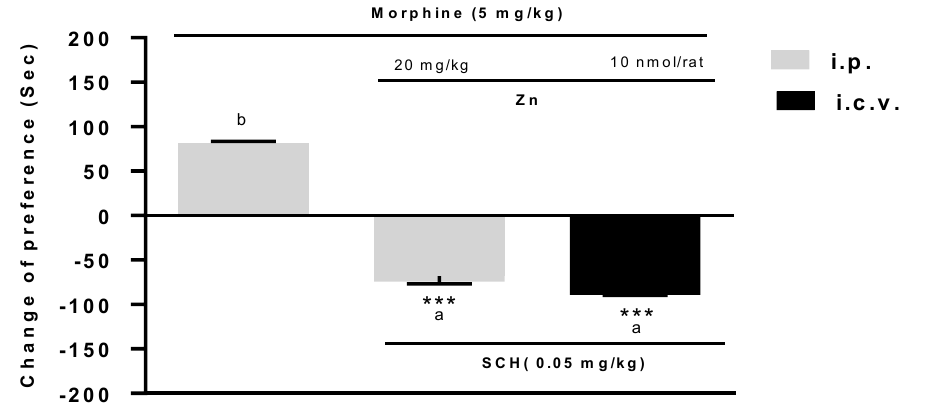
Figure 4. Effect of SCH23390 on the enhancement effect of Zn on the expression of morphine-induced CPP. Zn was given i.p. (20 mg/kg) and i.c.v. (10 nmol/rat) separately after the SCH23390 treatment in the post-conditioning sections. Each point represents the mean± SEM of six rats. *** Presents significant between saline (10 ml/kg, i.p.) group at P < 0.001. Different letters indicate significant differences between groups (p<0.05) (Tukey’s post-hoc test). Zn=Zinc, and Figure 4. Figure 4.